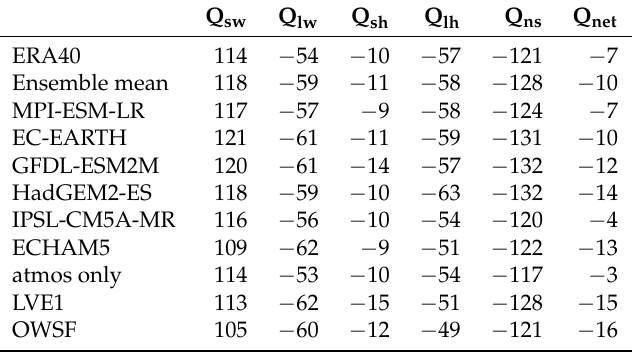
Table 3. Summary of climatological annual mean heat fluxes (W/m 2 ) during period P0 averaged over the North Sea for RCA4-NEMO hindcast and scenario experiments. The values for the atmosphere only ERA40 hindcast are listed as well. The last two rows represent data from Light Vessel Elbe 1 (LVE1) and Ocean Weather Ship Famita (OWSF) published by Moll and Radach [58]. The abbreviations